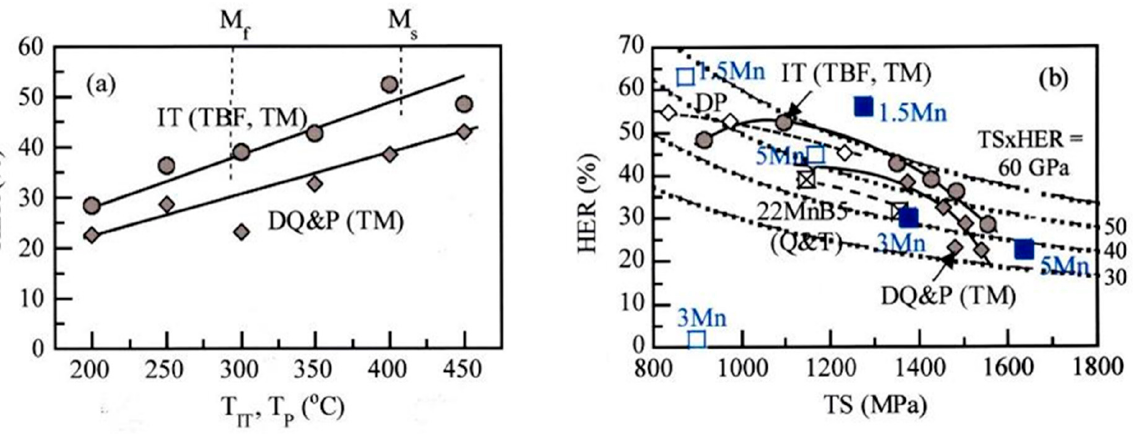
Figure 14. ( a ) Isothermal transformation and partitioning temperature ( T IT and T P ) dependences of hole-expansion ratio (HER) of 0.20C-1.50Si-1.50Mn-0.05Nb TBF and TM steels subjected to isothermal transformation (IT) process ( ● ) and TM steel subjected to a direct quenching and partitioning (DQ&P) process ( ◆ ) [51]. ( b ) HER − TS (tensile strength) relation in the IT-processed TBF and TM steels ( ● ) [51], the DQ&P-processed TM steel ( ◆ ) [51], 0.2C-1.5Si-(1.5-5.0)Mn (1.5Mn, 3Mn, and 5Mn)